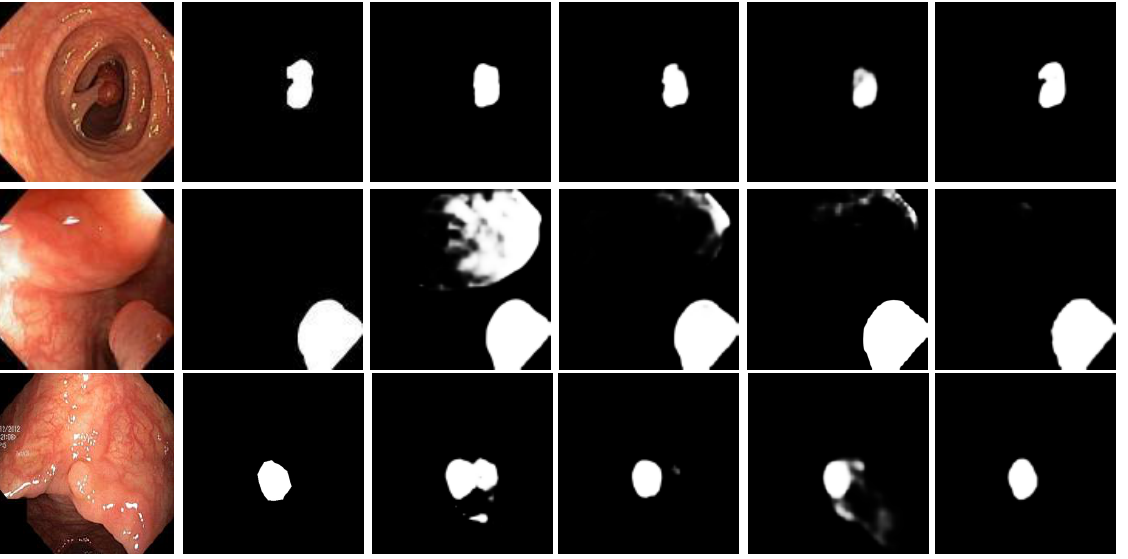
Figure 8. Comparison of segmentation results with and without MPFM from the Kvasir-SEG dataset. The image, the mask, the segmentation results of N/MPFM, GPG, CFM, and the proposed model are presented from left to right.